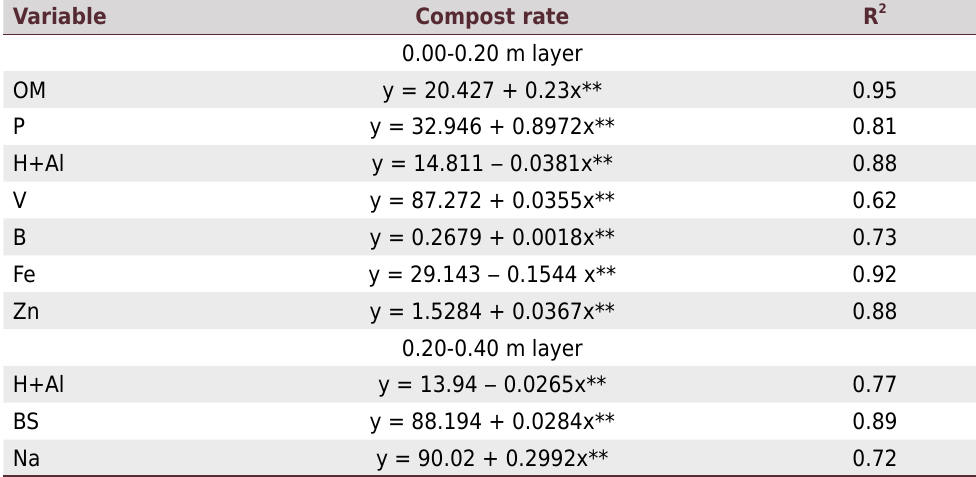
Table 4. Regression equation for the effect of organic compost rates on soil chemical properties in a forage field with elephant grass cv. Cameroon Variable